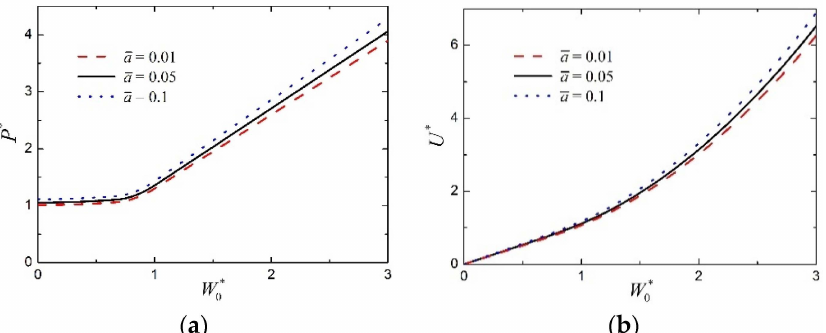
Figure 10. Influence of punch size on the large deflection response of FML sandwich beams trans- versely loaded by a flat punch ( c = 0.03, h f = 0.05, σ c = 0.1, n = 3, q = 2, f = 0.6): ( a ) Load versus midspan deflection; ( b ) absorbed energy versus midspan